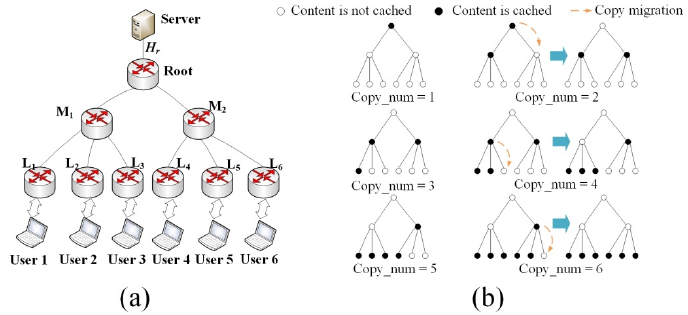
Figure 2. A case of placing copies of single content. ( a ) A three-level Cache Network System Model. (b)Multiple copy placement process of a single content